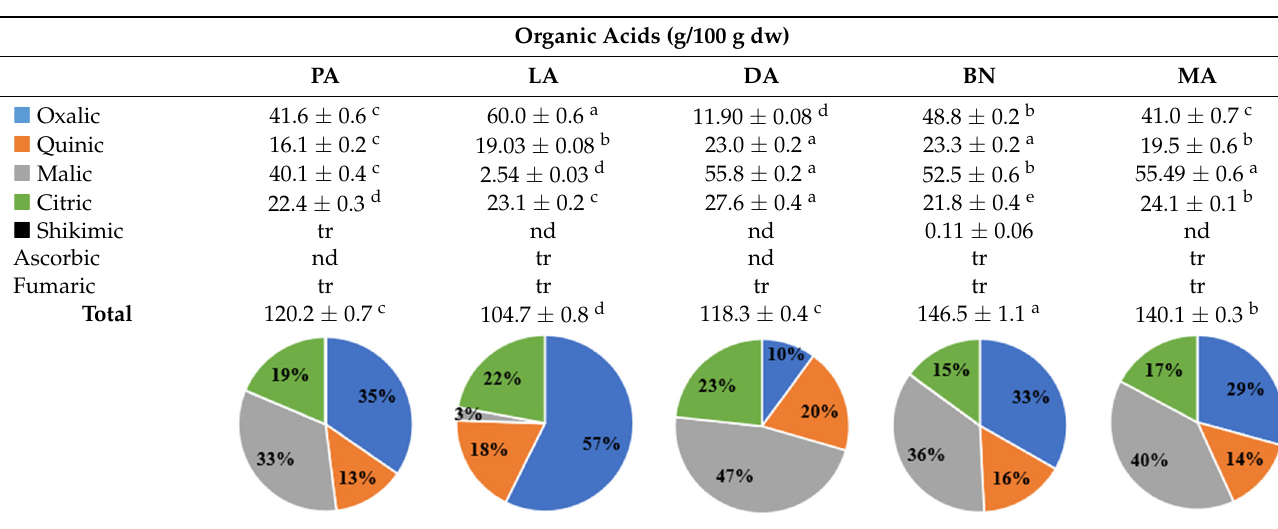
Table 2. UFLC-DAD characterization of organic acids composition in fig leaves.